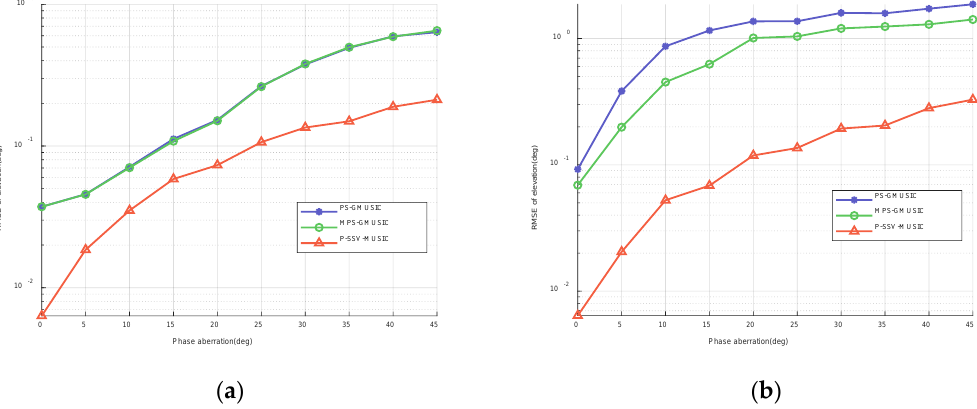
Figure 7. RMSE of elevation with respect to the phase aberration when SNR = 20 dB and T = 100: